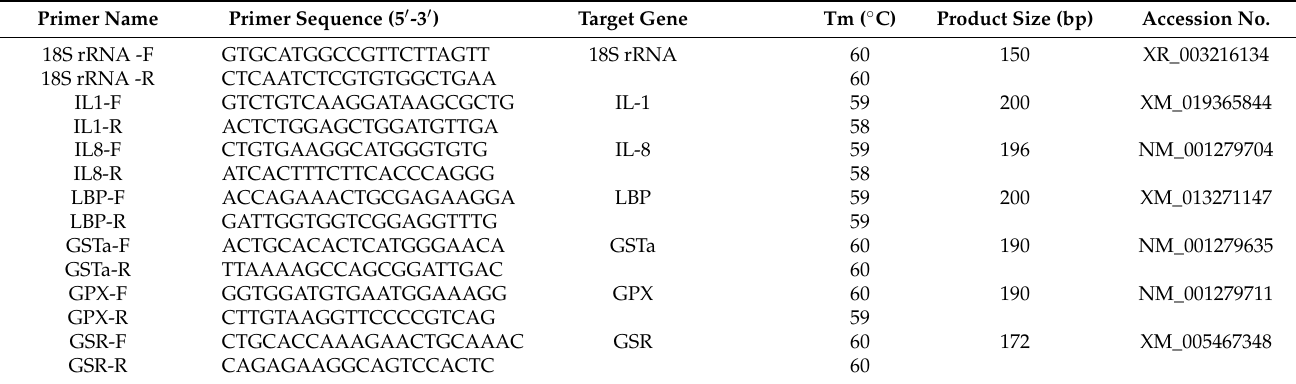
Table 2. Primer sequences, amplicons, and the related information for quantitative